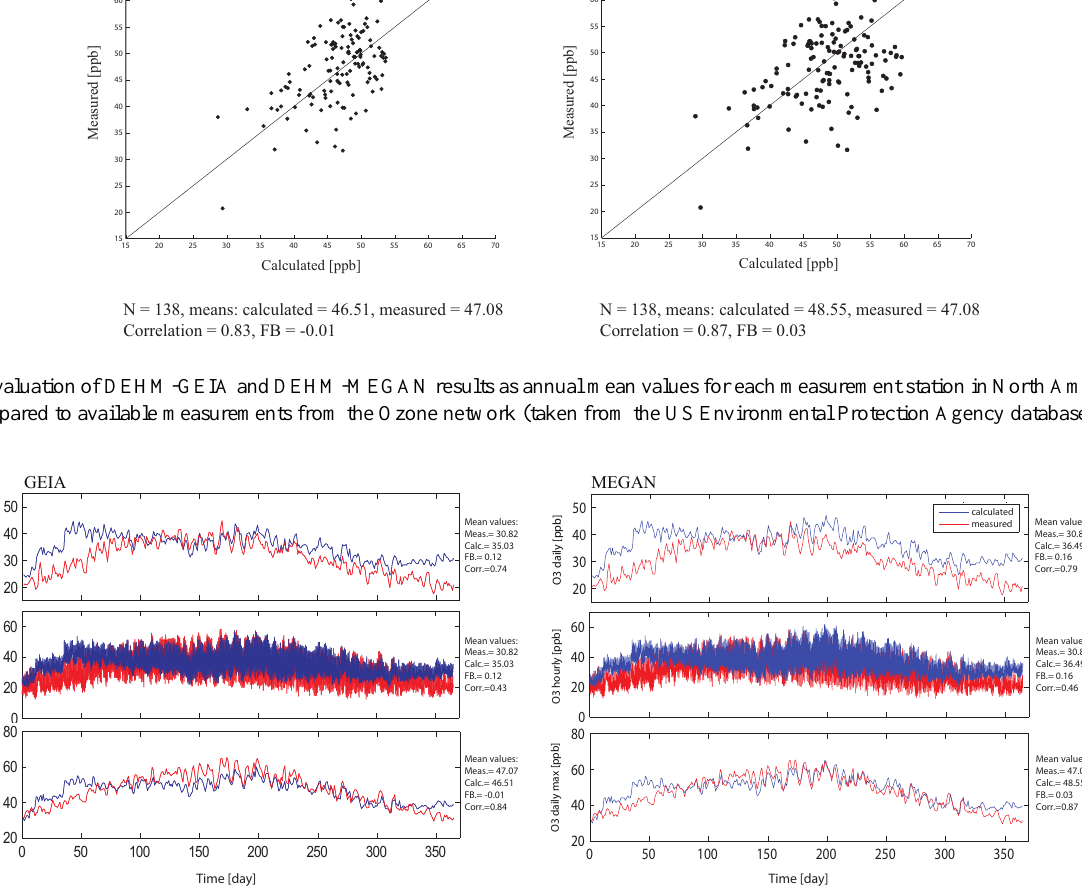
Fig. 15. Evaluation of DEHM results for daily mean, hourly and daily maximum ozone concentrations, using both GEIA and MEGAN for 2006 with available measurements from the Ozone network (taken from the US Environmental Protection Agency database) taken as average values in space over all the measurement